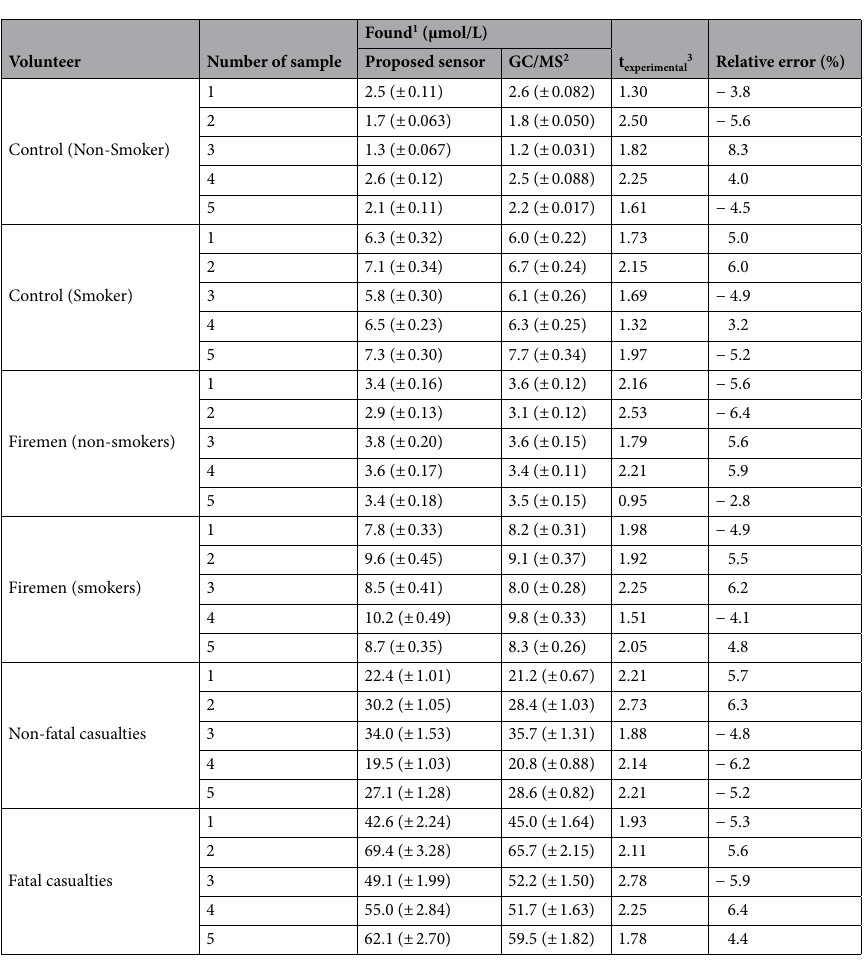
Table 3. Determination of cyanide concentration in the blood sample of fire survivors. 1 Mean of